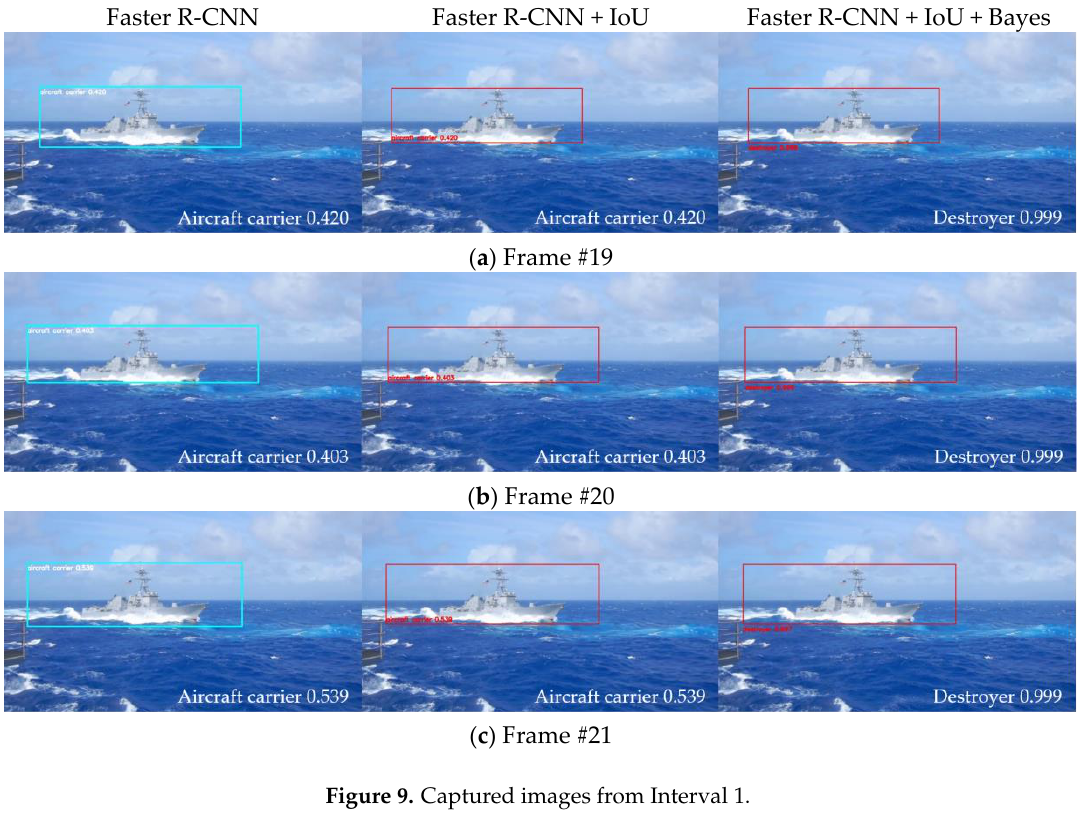
Figure 9. Captured images from Interval 1.